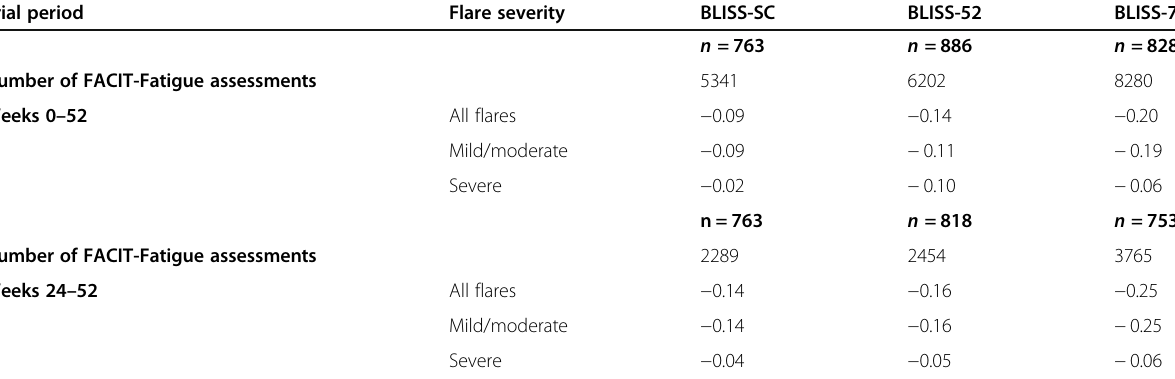
Table 3 Spearman correlations between mean FACIT-Fatigue scores, and number of SLE flares by severity and trial Trial